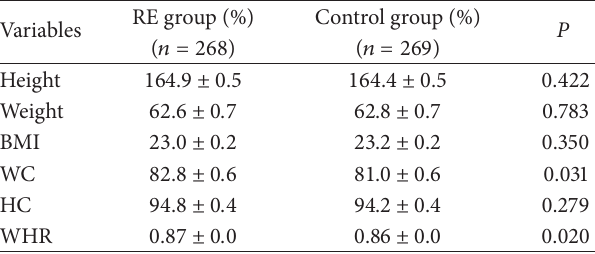
Table 2: Anthropometric measurements of RE group and